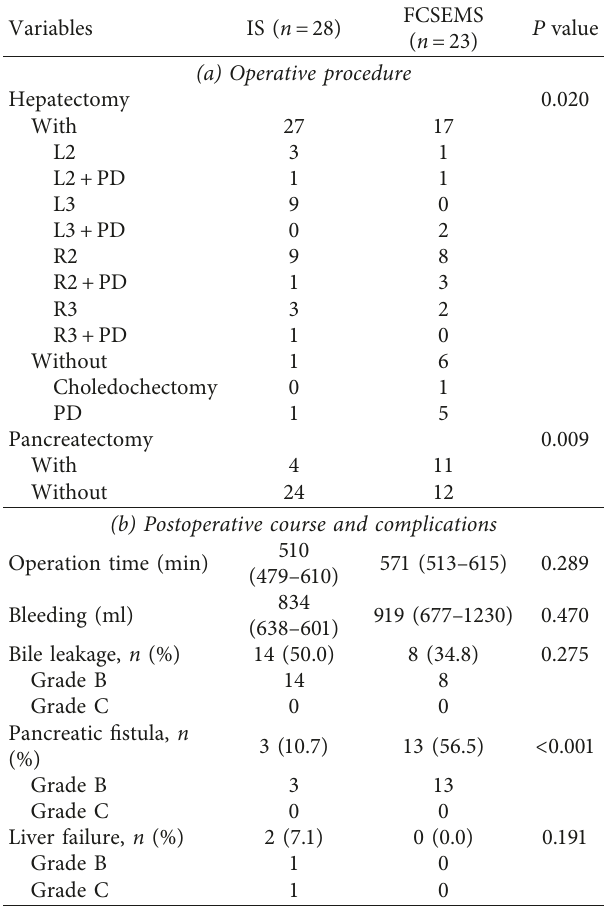
Table 3: Patients without reintervention.